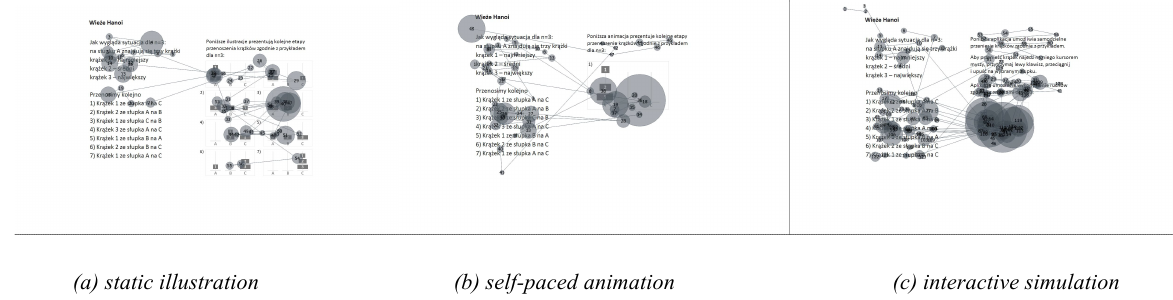
Figure 2. Towers of Hanoi problem with three types of multimedia instructional materials with recorded representative eye gaze scanpaths of relatively high working memory capacity individuals (static text at left is in Polish and explains the recursive